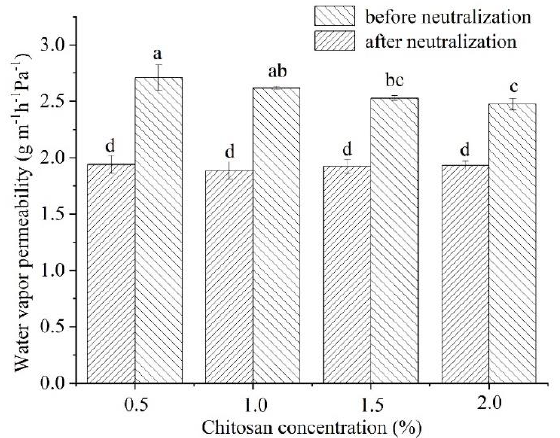
Figure 1. Effects of chitosan concentration on water vapor permeability of chitosan films before and after neutralization. Different letters indicate significant differences ( p <0.05).